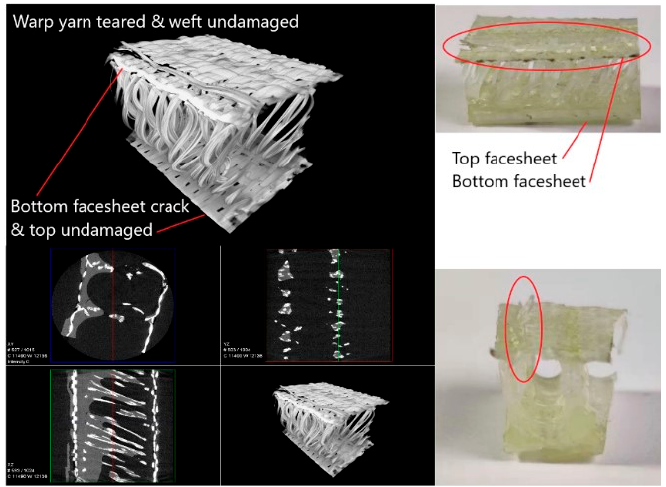
Figure 24. 3D X-ray microscopy image of warp compression fractured specimen.